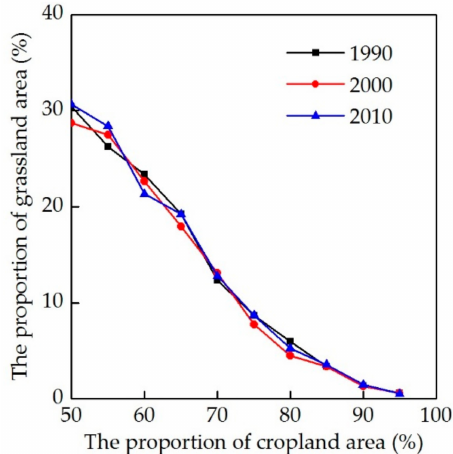
Figure 3. Proportional relationship between modern cropland and grassland